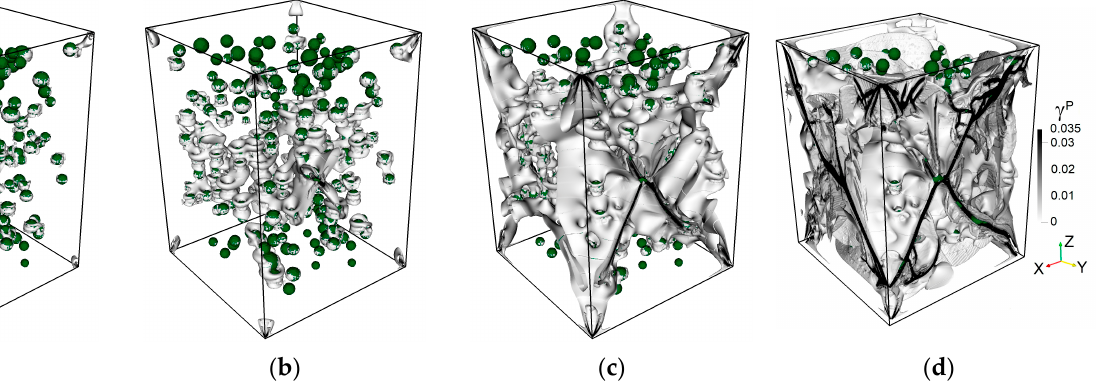
Figure 7. Stages of inelastic strain accumulation related to the corresponding states ( a – d ) in Figure 6. The color legend and orientations are the same as in state ( d ). Accumulated damage is represented in the bulk of the sample (grey and black colors) and is combined with the pore structure (pores are shown by dark green color).